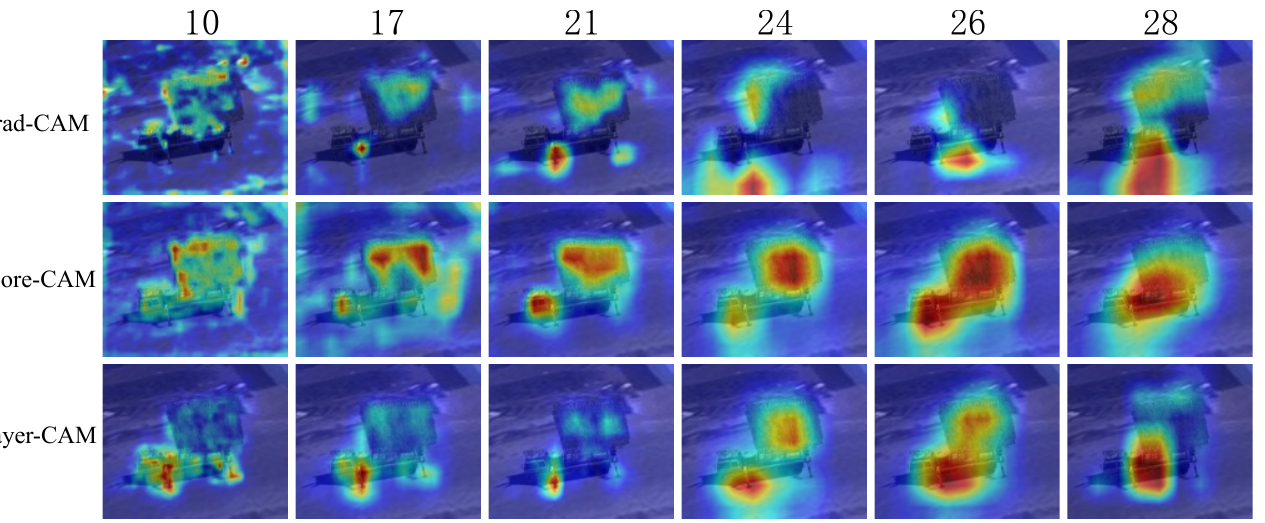
Figure 3. The comparison of different CAM